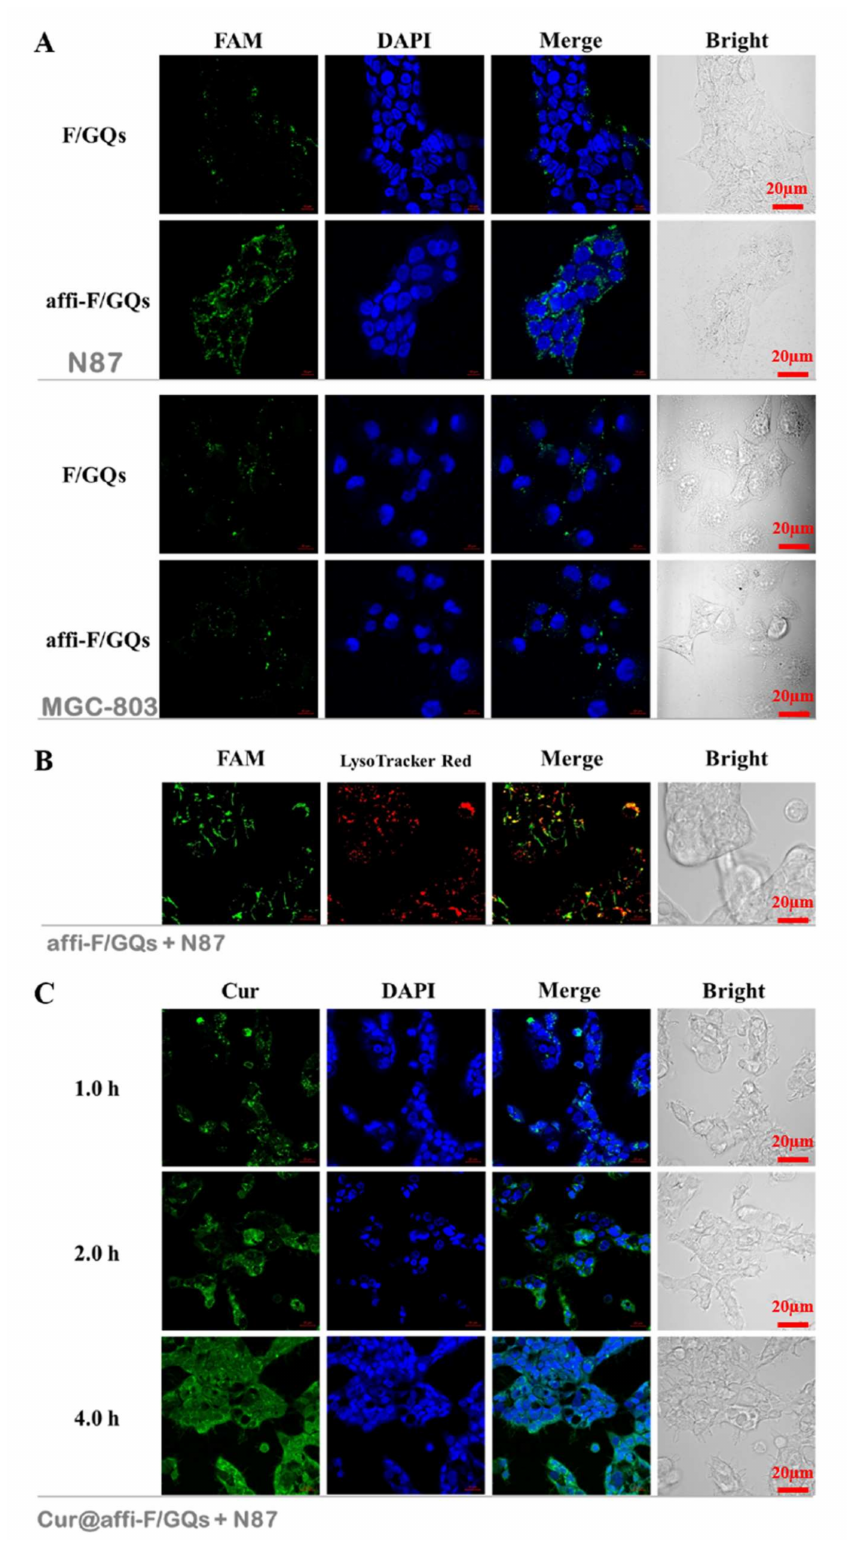
Figure 6. ( A ) Fluorescent microscopic photographs of N87 and MGC 803 cells treated with FAM- labelled F/GQs and affi-F/GQs, respectively, for 1 h (relative FAM = 5 µ M). ( B ) Colocalization studies of affi-F/GQs in N87 cells after incubation with lysosome tracker for 0.5 h. ( C ) Cur release from Cur@affi-F/GQs in N87 cells at predetermined times. Scale bar: 20 µ